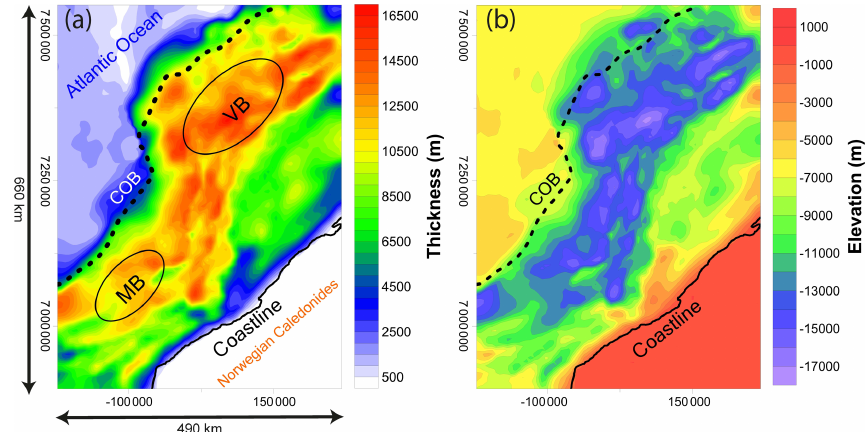
Figure 5. 3-D structural model of the Norwegian margin: (a) cumulative sediment thickness; (b) depth to top basement (COB: continent– ocean boundary, VB: Vøring Basin, MB: Møre Basin, UTM: WGS84, zone